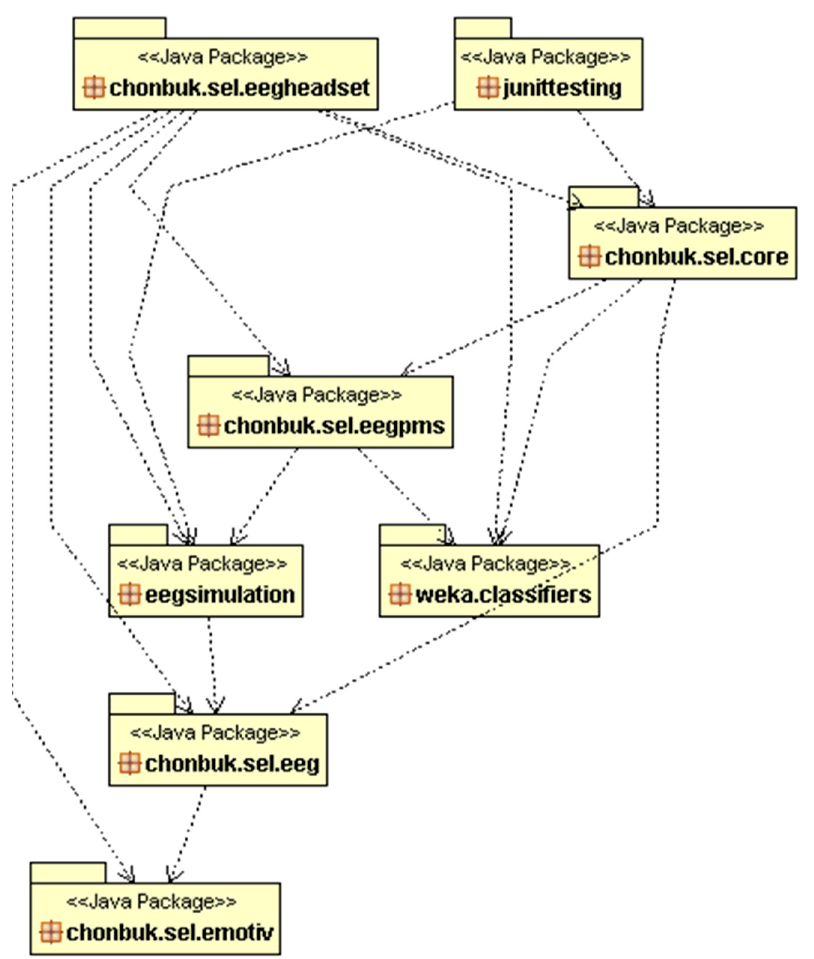
Figure 3. CAES package level diagram, includes most common packages in system